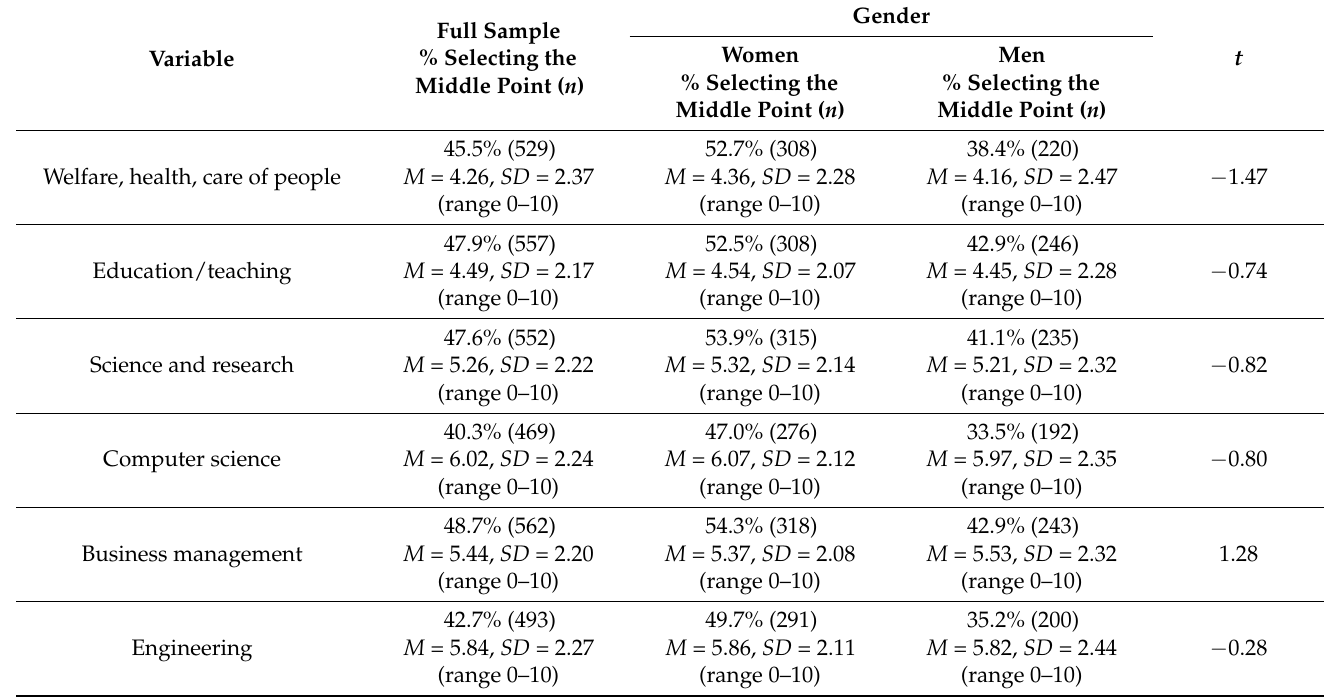
Table 4. Gender-based occupational stereotypes by